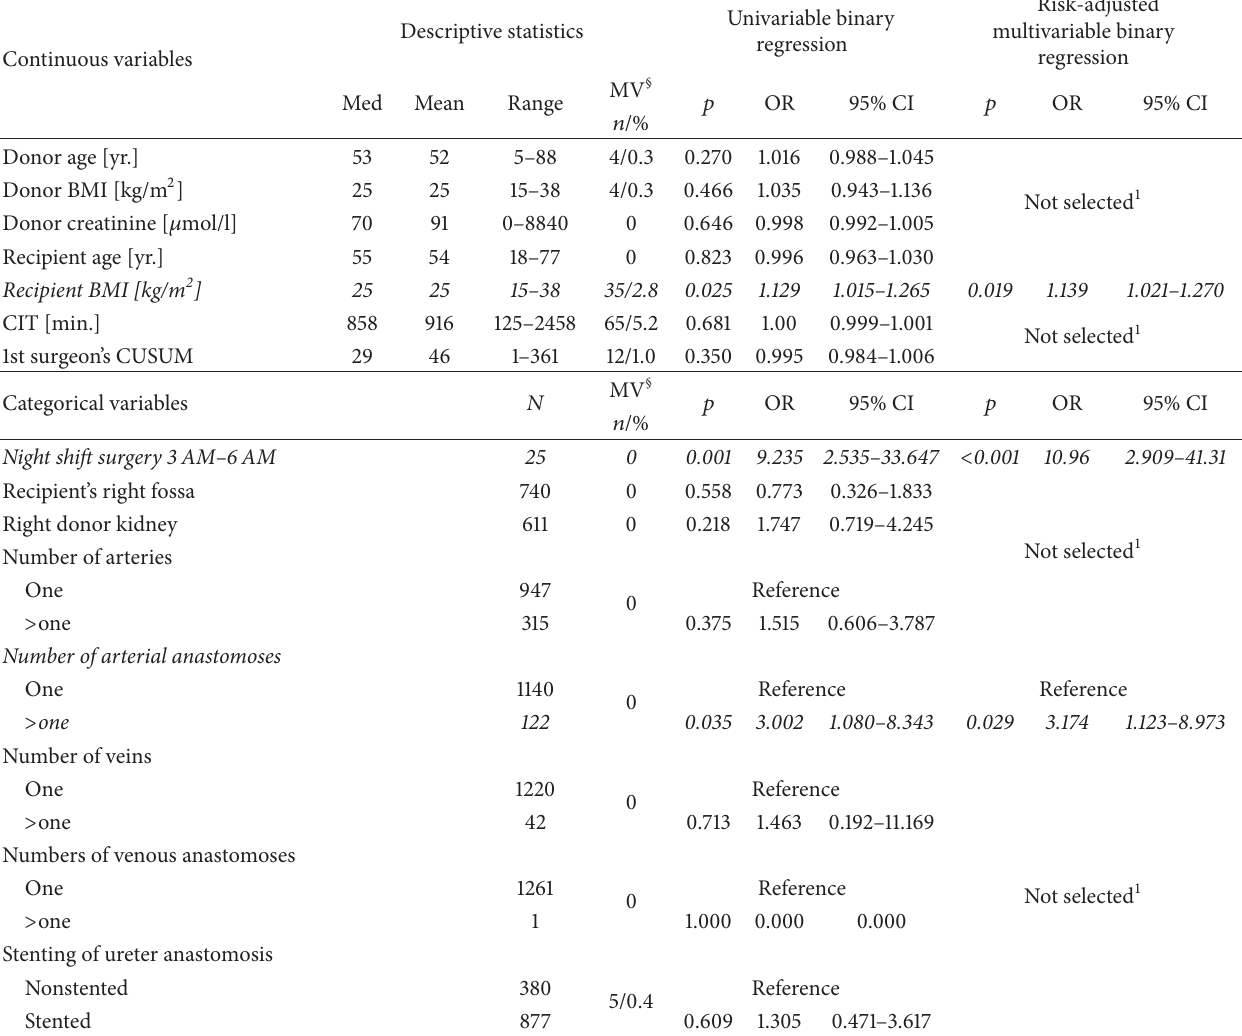
Table 5: Regression analysis of the risks of perioperativegraft loss due to surgical reasons ( 𝑛 = 21 ). Shown are the results of univariable and multivariable binary regression analyses to determine the odds ratios of the investigated variables for the risk of perioperativegraft loss due to surgical reasons ( 𝑛 = 21 ). Analyzed were all 1262 cases with standard kidney transplantations into nonpreoperated sites between 1 January 2000 and 31 October 2013. Included into risk-adjusted multivariable analyses were only transplant variables with a 𝑝 value < 0.2 in univariable regression